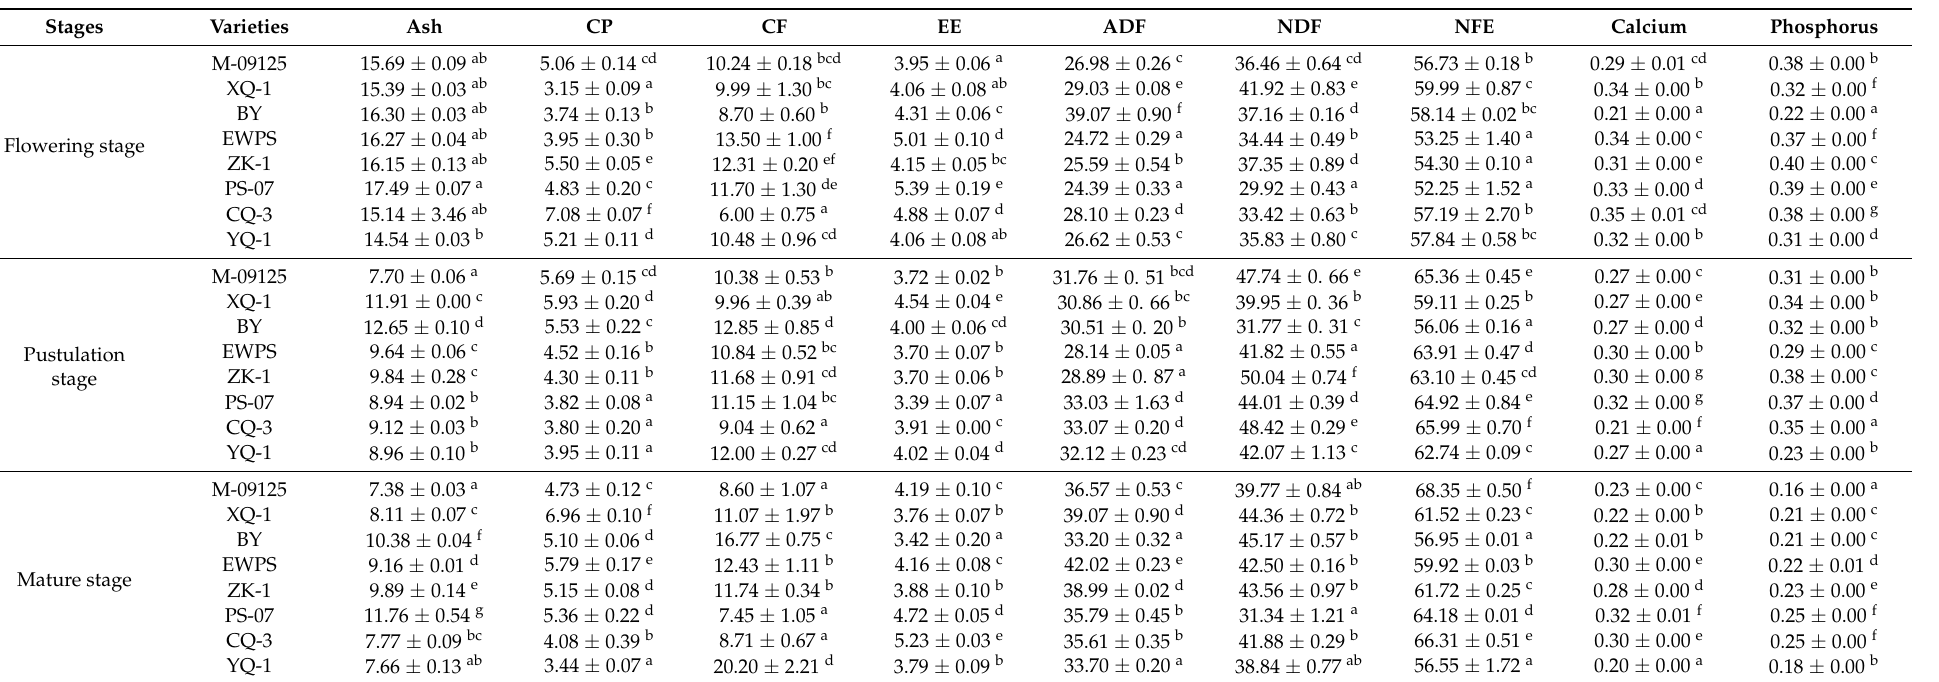
Table 1. Nutritional contents of eight tartary buckwheat varieties at different growth stages on a dry matter basis